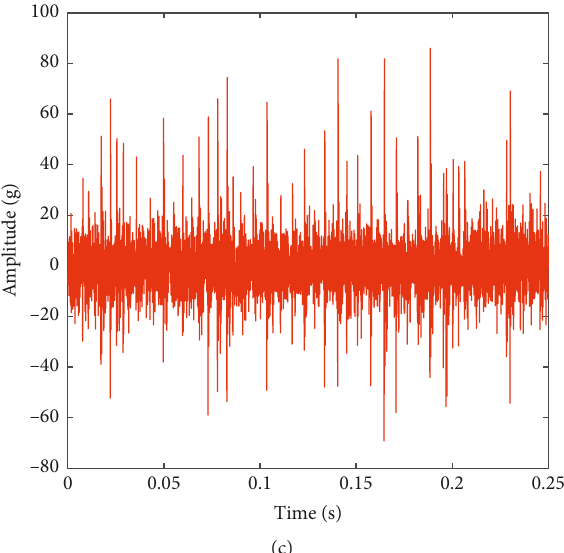
Figure 5: The time-domain vibration signals under three states of spiral-bevel gears. (a) Normal tooth. (b) 1/3 broken tooth. (c) 2/3 broken